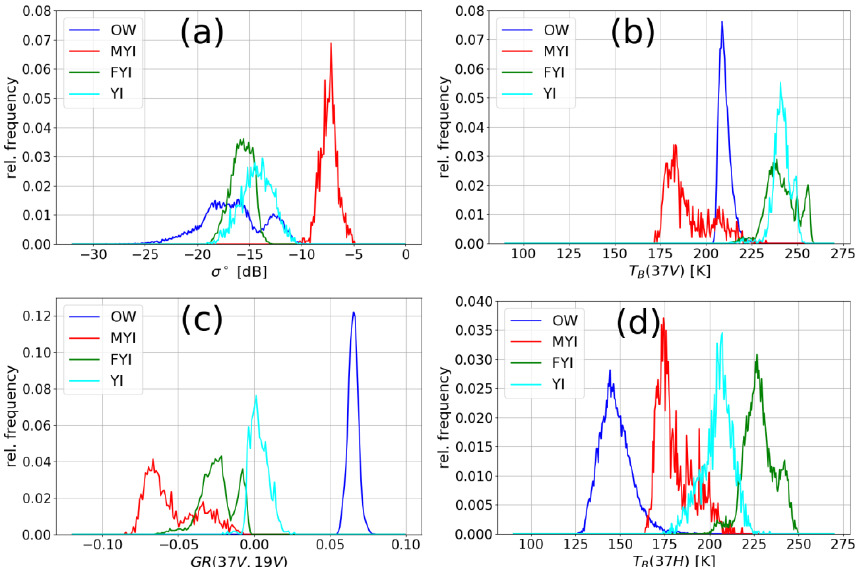
Figure 2. Distributions of the four input parameters for ECICE for the Antarctic surface types MYI (red), FYI (green), YI (cyan), and open water (blue) for the sample areas specified in Appendix A: (a) ASCAT σ ◦ ; (b) AMSR2 T B at 37GHz, V polarisation; (c) AMSR2 T B at 37GHz, H polarisation; and (d) AMSR2 GR (37V, 19V). Total number of samples: OW: 13742, MYI: 964, FYI: 6852, YI: